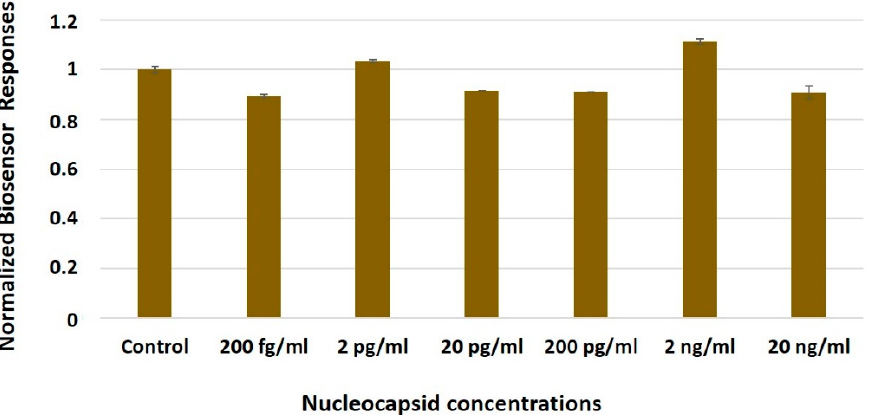
Figure 4. Biosensor cross-response against the SARS-CoV-2 nucleocapsid (NC) protein in the 200 fg/mL–20 ng/mL concentration range. Membrane ‐ engineered SK ‐ N ‐ SH/ACE2 cells were utilized as the biorecognition element. Results are presented after three minutes (brown columns) of sample– cell interaction and are expressed as ratio to control ( n = 16).